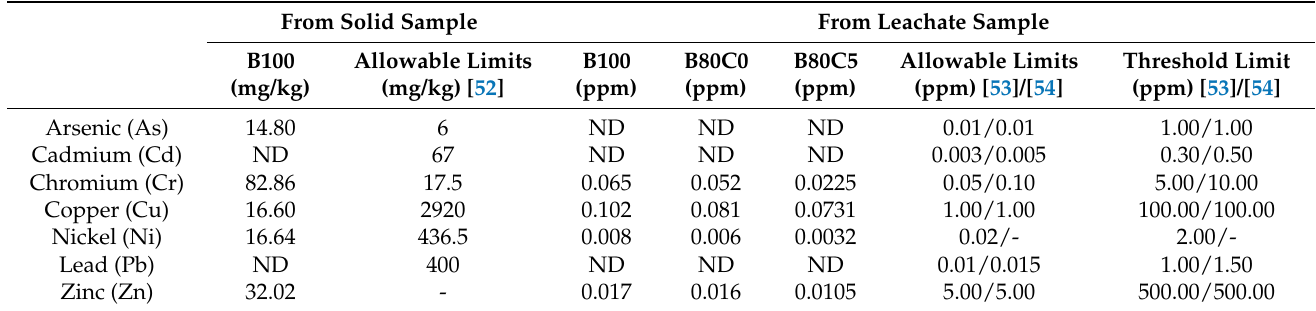
Table 5. Heavy metal